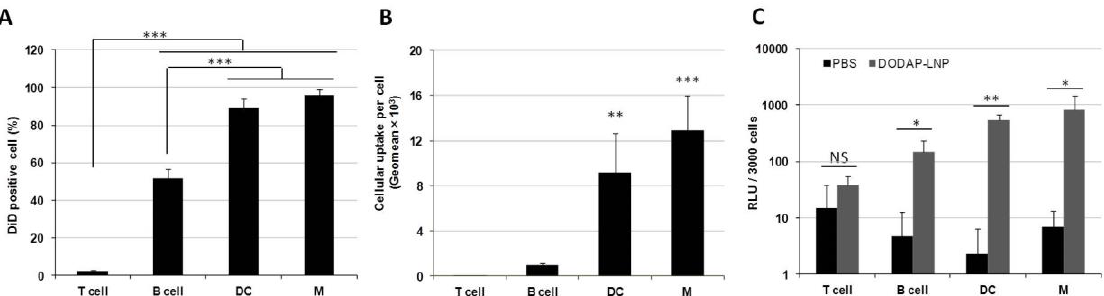
Figure 2. The cellular uptake and gene expression in splenocytes. Different LNPs were prepared by the ethanol dilution method and labeled with 1 mol% DiD. Splenocytes were isolated at 24 h after the injection of 400 µL LNPs. ( A ) DiD positive cells (%) in each cell type, *** p < 0.001, Tuk- ey-Kramer test. ( B ) Geo-mean fluorescence intensity in each cell type, *** p < 0.001, ** p < 0.01, Tukey-Kramer test. ( C ) Luciferase activity per 3000 cells, * p < 0.05, ** p < 0.01, NS: not significant, Student t